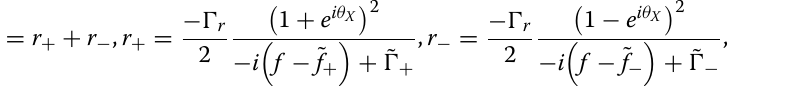
Fig. 2 Generic phase diagram for the bi-layer metasurfaces. a Reflectance of the 2-mode 2-port model (inset) calculated by Eq. (3) in the main text, as a function of frequency, θ X and κ , with κ on the horizontal curved surface. Green dash lines labeled with #1 to #4 represent the cases of κ /Γ r 0, 0.6, 1 with fixed θ X π /2, while those labeled with #4 to #7 represent the cases of θ X − − = π with κ Im( X ) 0 satisfied, respectively. Here, Γ r / f 0 0.2. b - c Calculated reflection spectra | r | 2 and those − = = contributed by two decoupled modes | r | 2 calculated by Eq. (3) for 6 systems corresponding to 6 dashed ± lines shown in a . d Upper panel: spectra of | r | 2 and | r | 2 calculated by Eq. (3) for the #4 system; Lower panel: ± computed spectra of transmittance and transmission phase for the #4